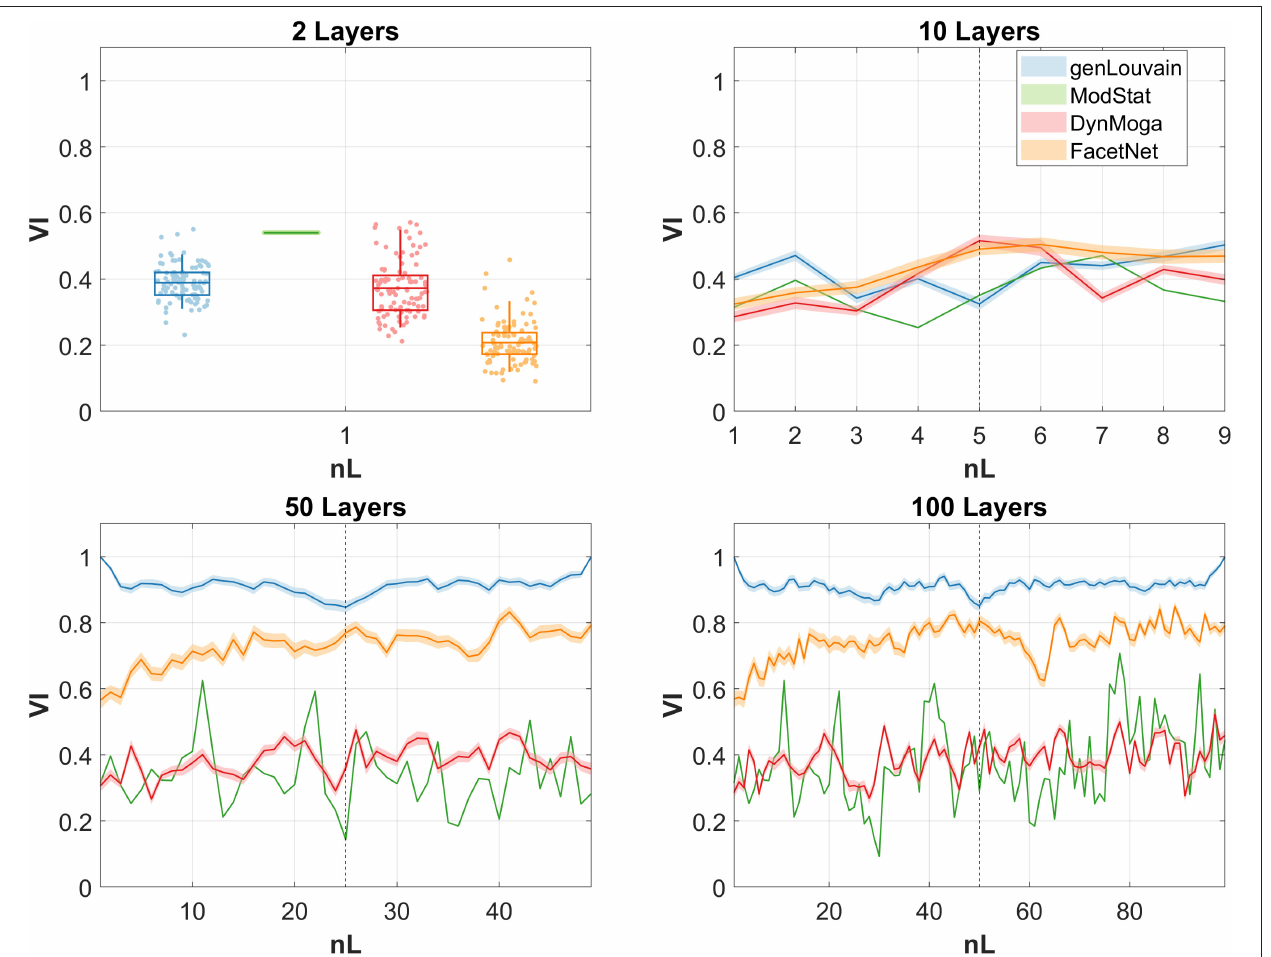
FIGURE 5 | Normalized mutual information (NMI) computed between the output of the algorithms, identified with a color code, at consecutive layers of the multilayer network. As we run the algorithms 100 times, we report the means of the NMI at each snapshot, bounded by the confidence interval, represented with a lighter color. Each graph corresponds to one of the four networks extracted with different numbers of